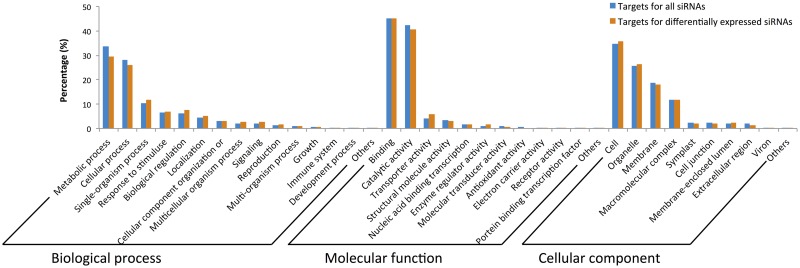
GO analysis of targets of phased and non-phased siRNAs.The GO analysis of targets of phased and non-phased siRNAs is shown, and GO terms are grouped by Biological process, Molecular function, and cellular component. Targets of all secondary siRNAs are shown in blue, while targets of differentially expressed siRNAs are shown in dark orange.